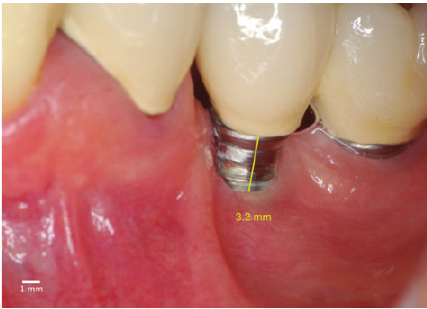
Figure 16: Initial appearance. Note exposure of threads and the absence of keratinized